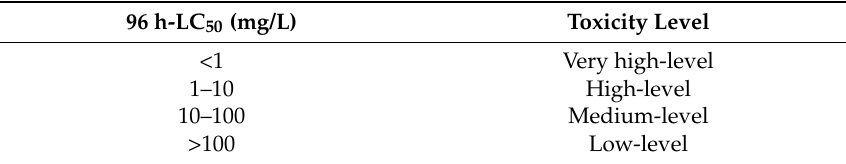
Table 3. Acute toxicity test classification criteria for